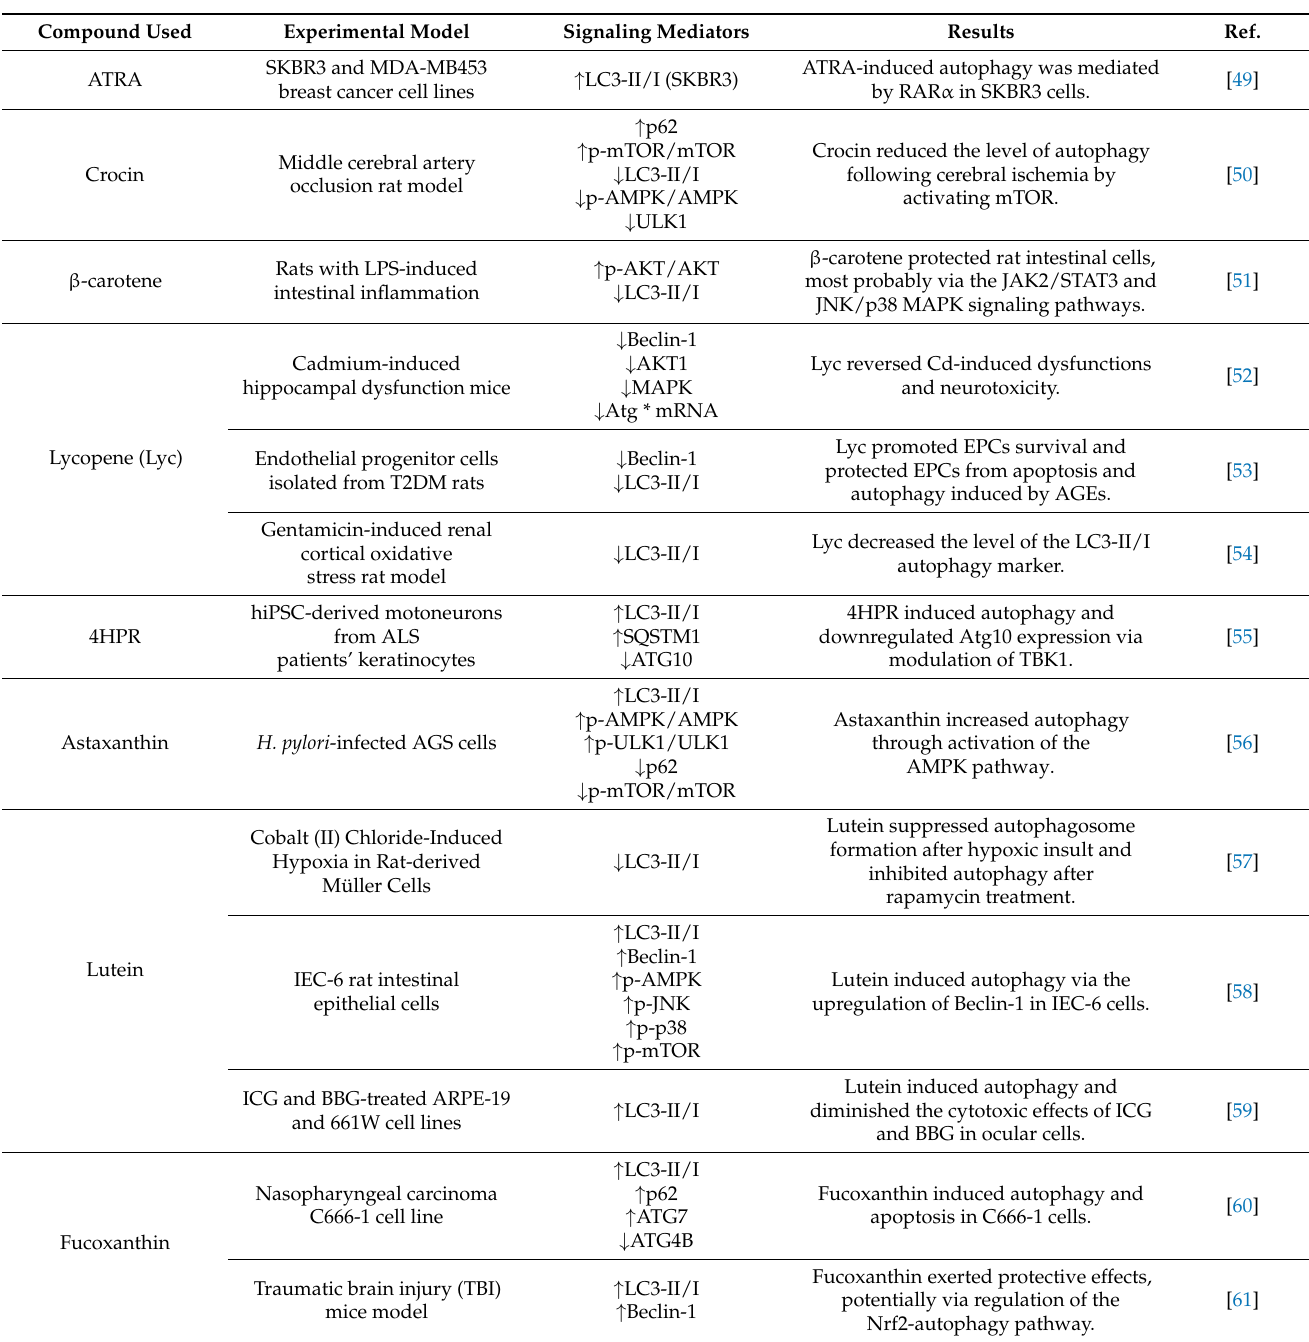
Table 1. Summary of selected available reports on the modulation of autophagy with vitamin A and its